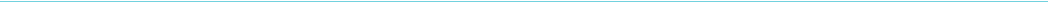
Figure 4: Risk for delayed graft function or organ loss after liver (A), left kidney (B), and right kidney (C) transplantation from 2011 to 2019. Presented are odds ratios (ORs) with 95% confidence intervals (95% CI) of multivariable logistic regression of the 72-hour post-trans- plant recipient graft function. In the case of the continuous variables donor age, creatinine and cold ischaemia time, ORs correspond to an in- crease of 1 year, 1 μmol/l, and 1 minute respectively. CPR: cardiopulmonary resuscitation; cDCD: controlled donation after circulatory